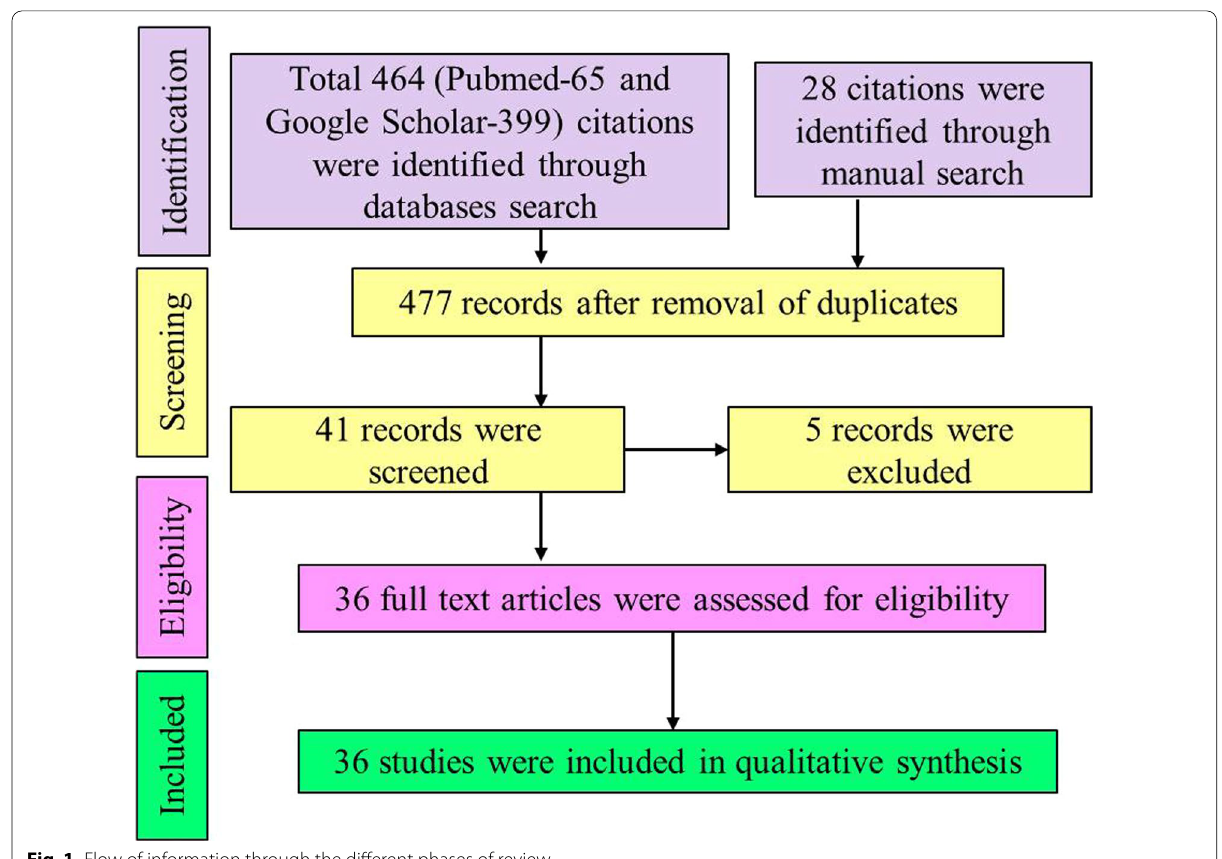
Fig. 1 Flow of information through the different phases of